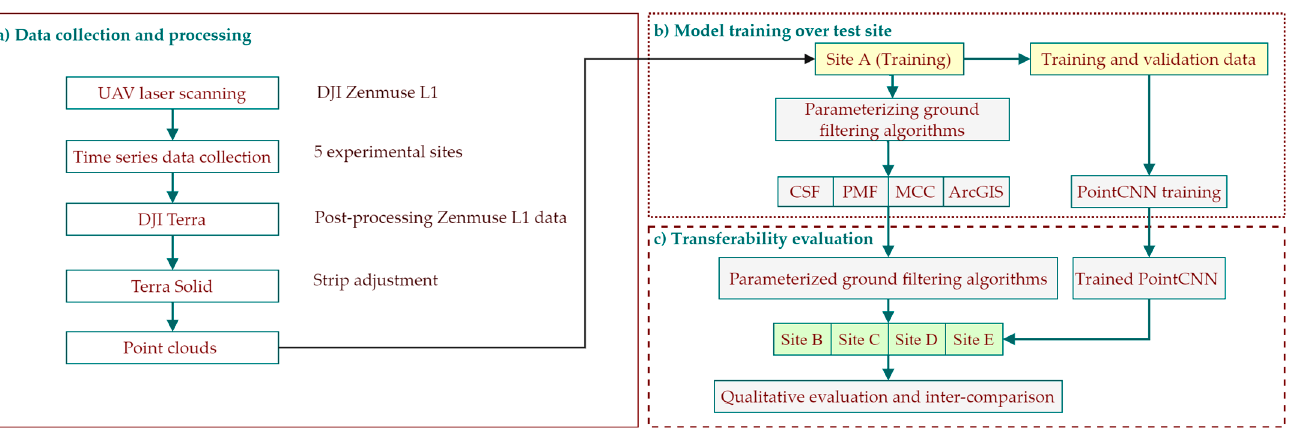
Figure 1. The schematic study designs: ( a ) Data collection and processing. ( b ) Parameter’s optimization of ground classification algorithms and training PointCNN over Site A. ( c ) Transferability evaluation of ground classification algorithms and PointCNN over representative test sites.